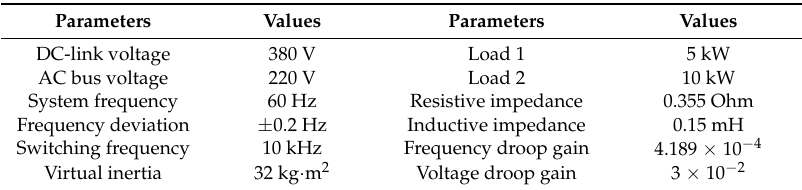
Table 1. System parameters.